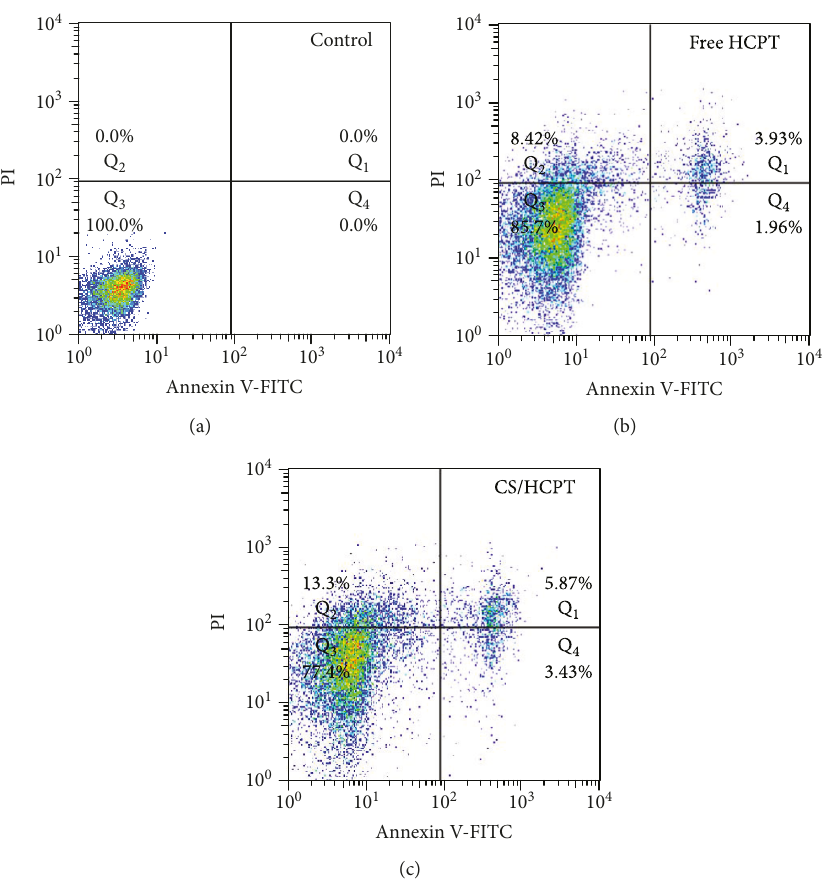
Figure 4: Apoptotic cell populations were determined by FCM analyses with Annexin V-FITC and PI staining after coincubating 4T1 cells with PBS, free HCPT, or CS/HCPT for 24h. The lower left (Q3), lower right (Q4), upper right (Q1), and upper left (Q2) quadrants in each panel indicated the populations of normal, early and late apoptotic, and apoptotic necrotic cells,